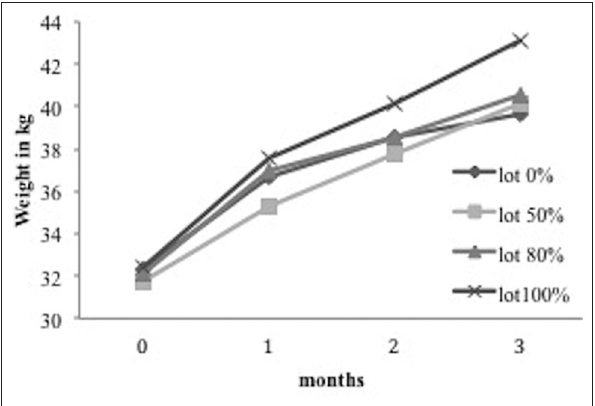
Figure-1: Change in live weight according to the substitution rates.